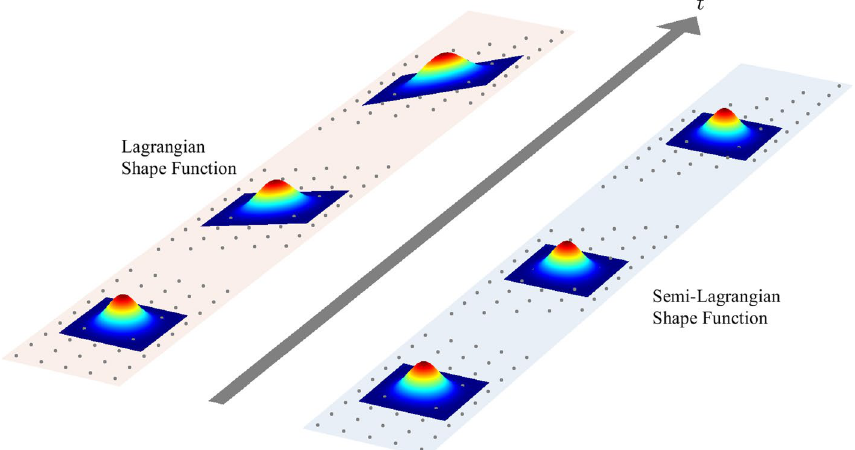
Fig. 2 Lagrangian and semi‑Lagrangian shape functions under progressive deformation. The shape functions are plotted only on their kernel support. The gray points denote nodal